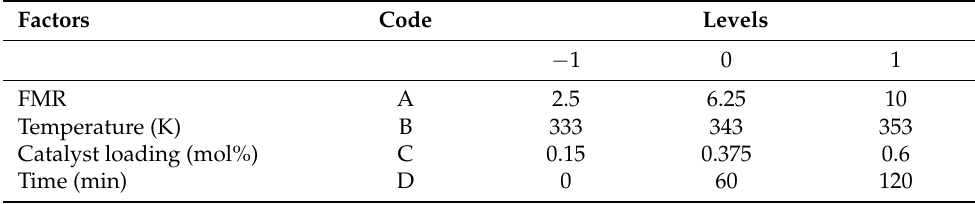
Table 2. Experimental design variables and their coded